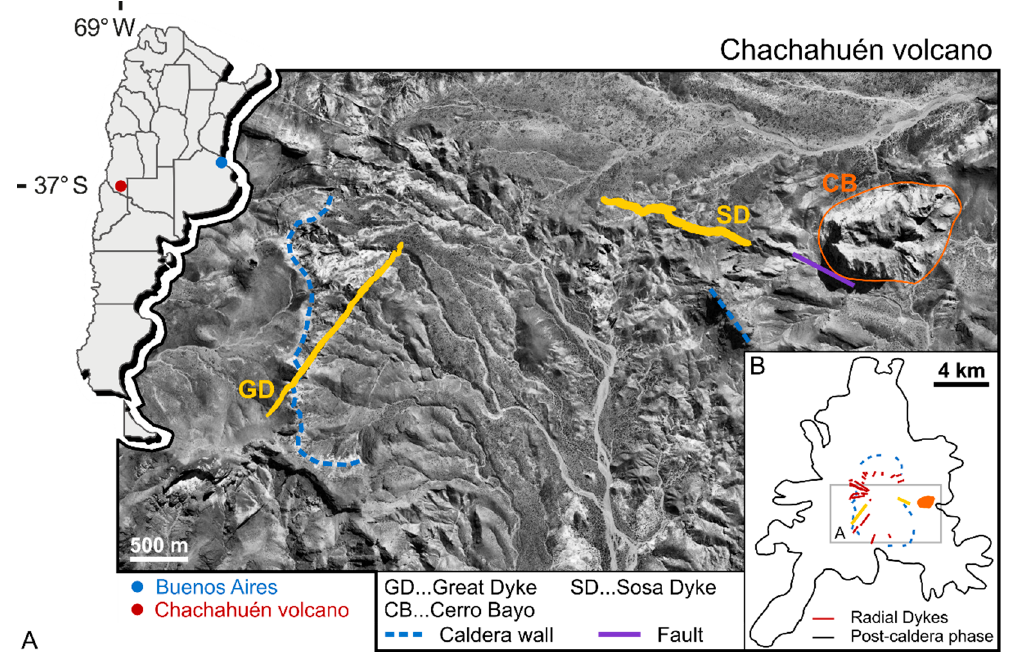
Figure 1. Overview of Chachahu é n volcano ( A ) Map of Argentina for location (modified after Drawnhy97-Freepik.com). Dykes in this study (yellow): Great Dyke (GD) and Sosa Dyke (SD); Cerro Bayo Cryptodome (CB, orange outline) from [49] on satellite photo: (Source: Google Earth). ( B ) Schematic drawing of Chachahu é n volcano outline of andesitic block-and- ash-flows and andesitic lavas in the post-caldera phase. Similar to ( A ) dykes in this study (yellow): Great Dyke and Sosa Dyke; Cerro Bayo Cryptodome (orange shape); Caldera outline (blue dashed